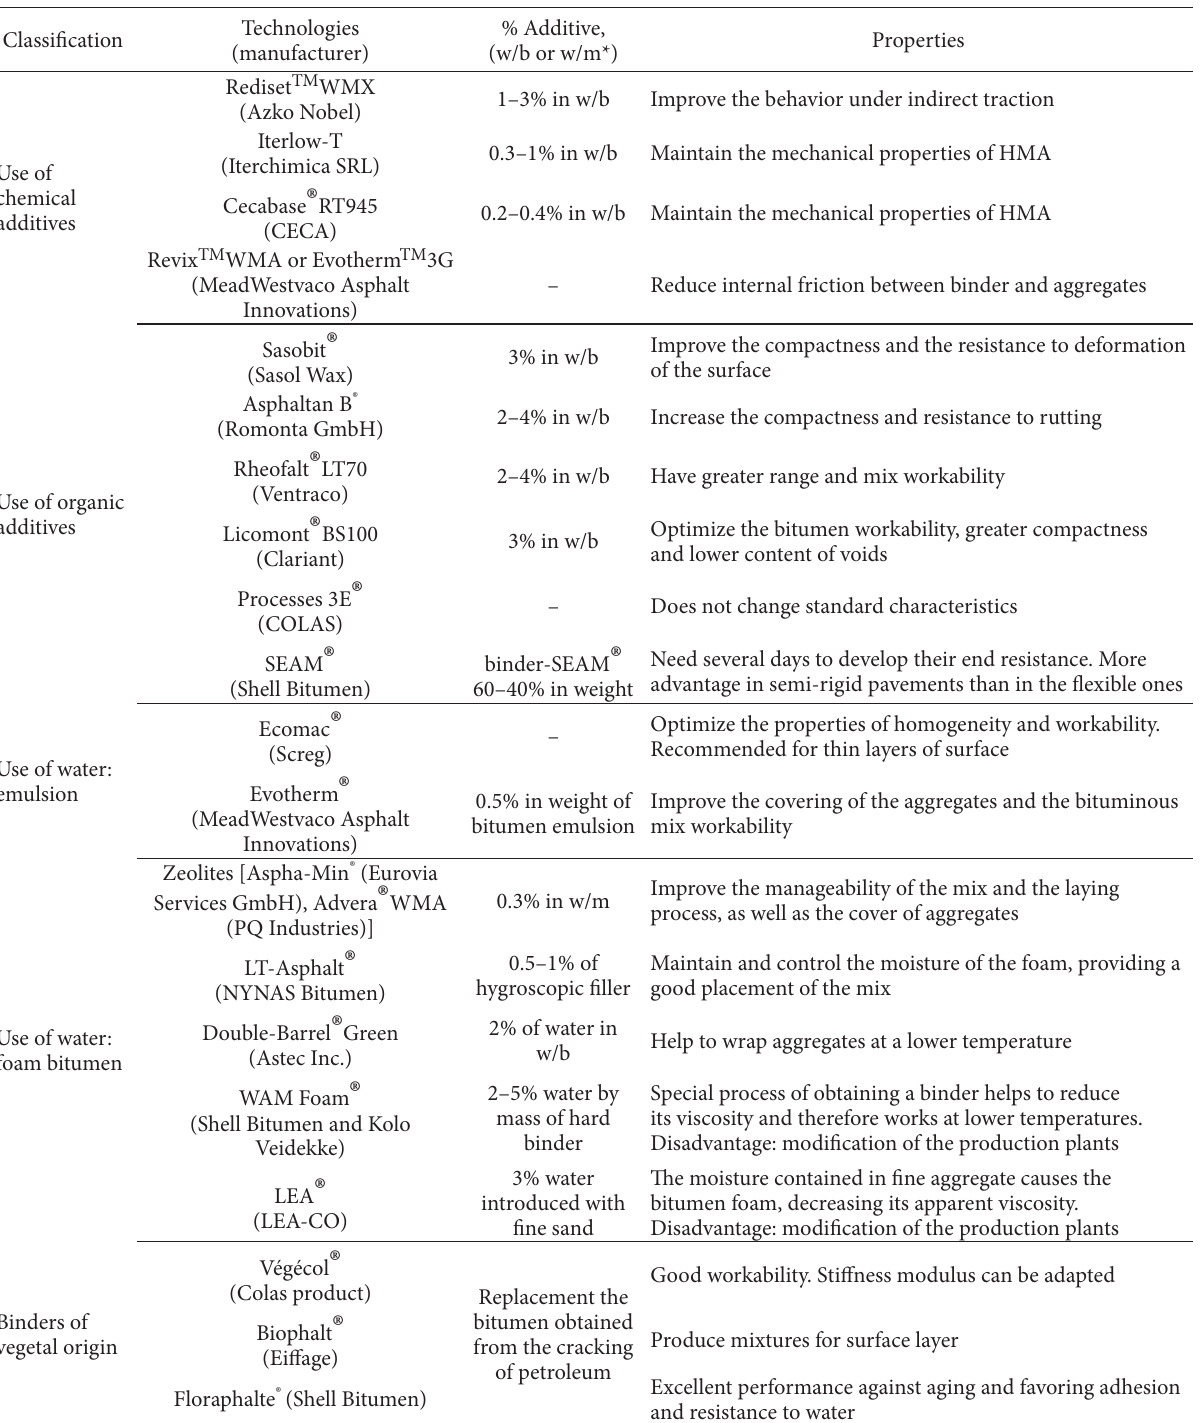
Table 1. Comparison of different technologies existing in sustainable asphalt mixes